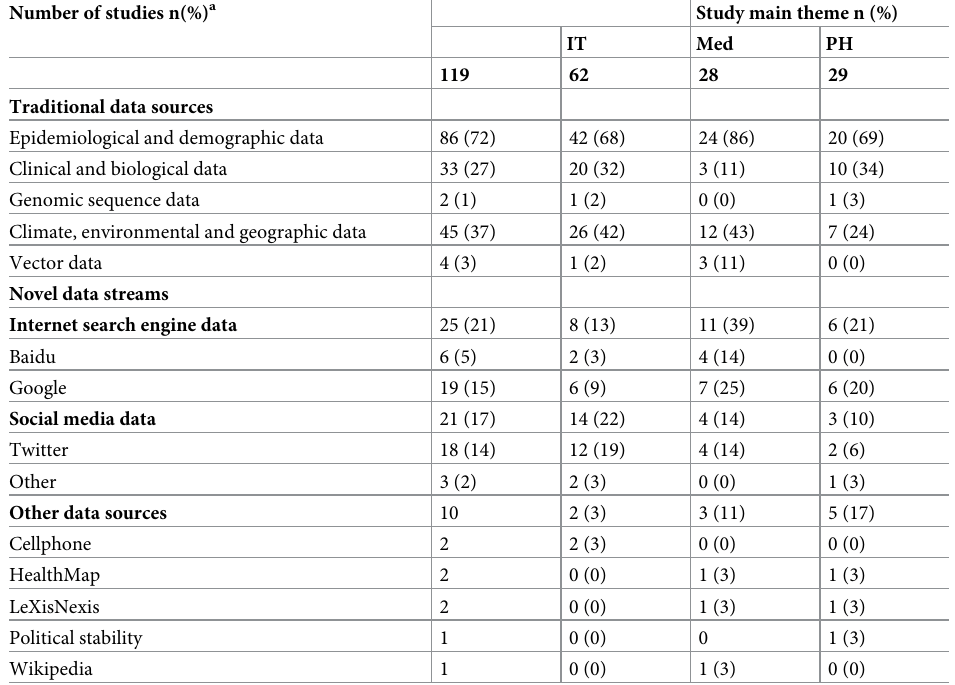
Table 2. Data sources for dengue monitoring and prediction depending on the main theme. Number of studies n(%) a